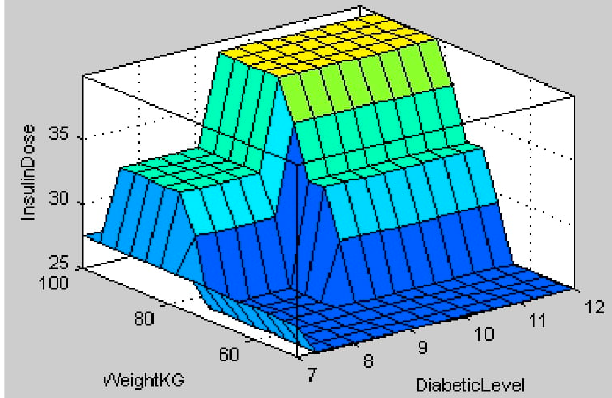
Figure 18. Surface view output for Inputs Diabetic Level and Carbohydrate Intake.